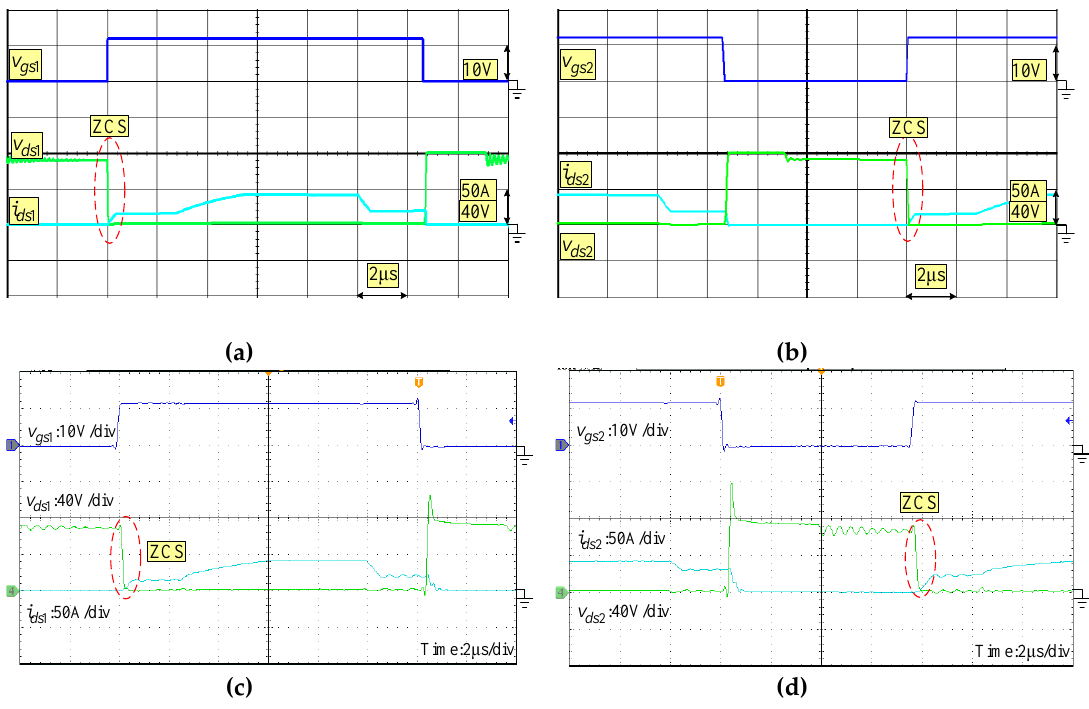
S and S . ( a ) and ( b ) simulated results. ( c ) 1 2